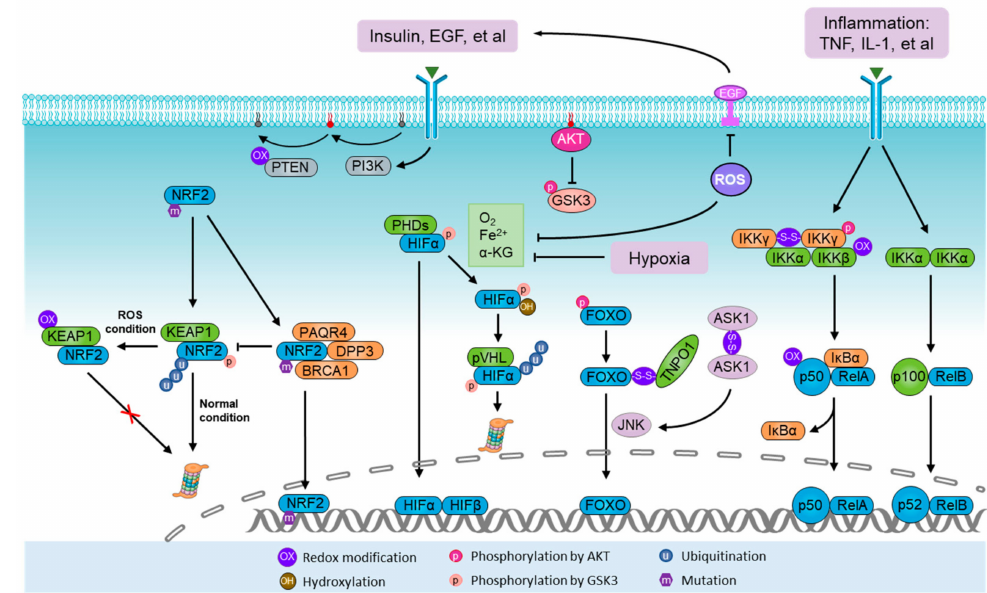
Figure 2. Activation of ROS sensors and metabolic modulators. NRF2-Kelch-like ECH-associated protein 1 (KEAP1) system represents the paradigmatic reactive oxygen species (ROS) sensor